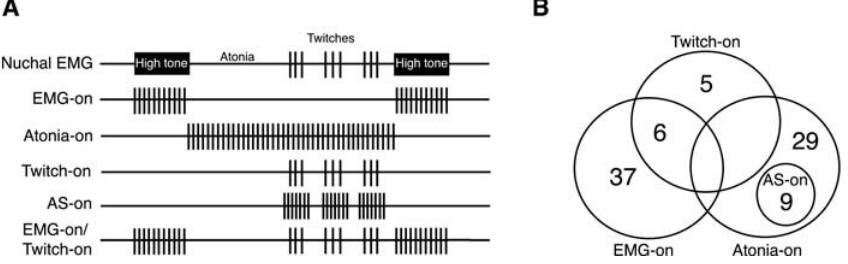
Figure 3. Schematic Representation of the Classes of Neurons Identified in the Current Study and Their Prevalence (A) Summary of the classes of discharge profiles described in the present study in relation to nuchal EMG activity. (B) Venn diagram depicting the interrelation of the classes of state-dependent neurons. Values indicate the number of neurons in each class found in the present study. DOI: 10.1371/journal.pbio.0030143.g003 PLoS Biology |